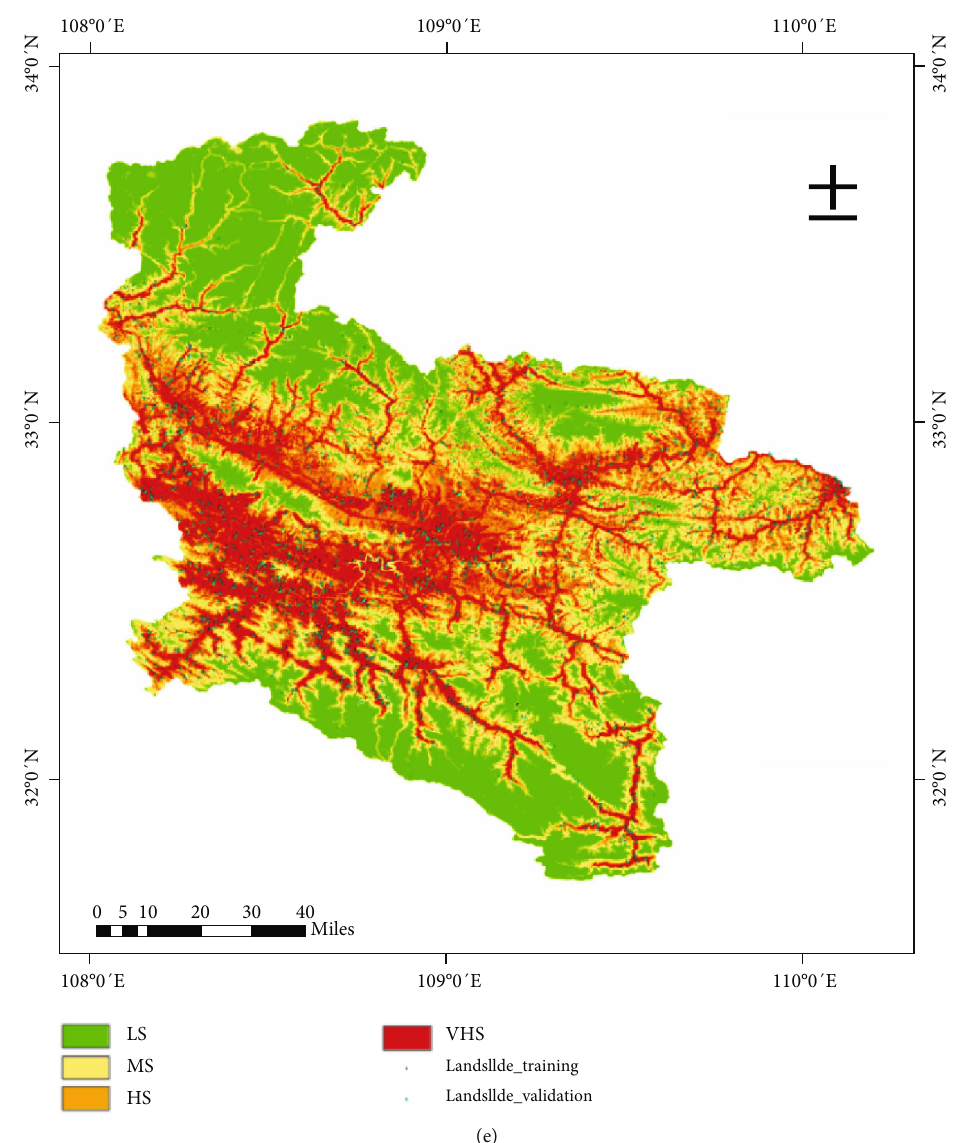
Figure 7: Landslide susceptibility maps based on di ff erent models: (a) LSM by LR; (b) LSM by SVM; (c) LSM by RF; (d) LSM by WOA-RF; (e) LSM by